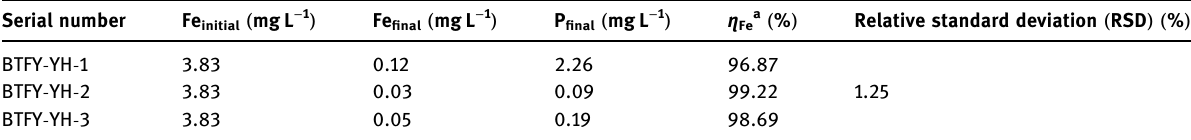
Table 2: Analysis results of fi ltrate after iron and aluminum separation under optimized conditions Serial